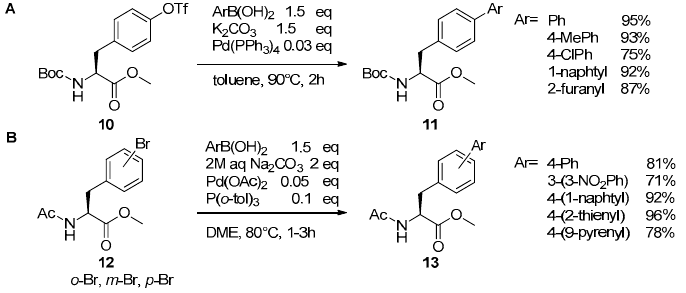
Figure 3. ( A ) First report of Suzuki–Miyaura reaction on 4-triflyloxyphenylalanine [86]. ( B ) Protected bromophenylalanines as substrates for cross-coupling.